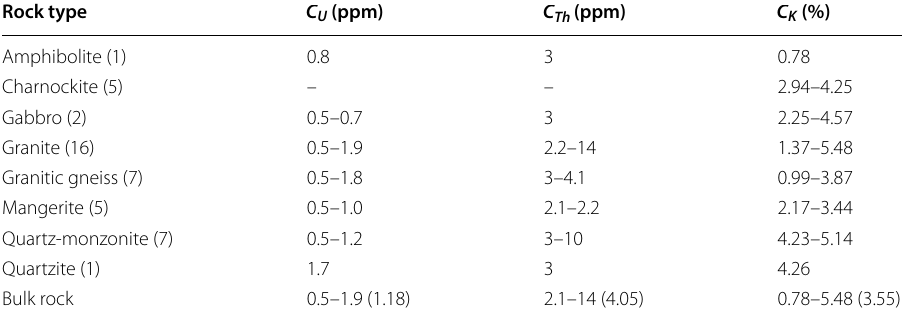
Table 5 Concentration of radiogenic elements of rocks from Rivière–à-Pierre suite in the Parc des Laurentides domain Data sources: (SIGÉOM 2018; Higgins and van Breemen